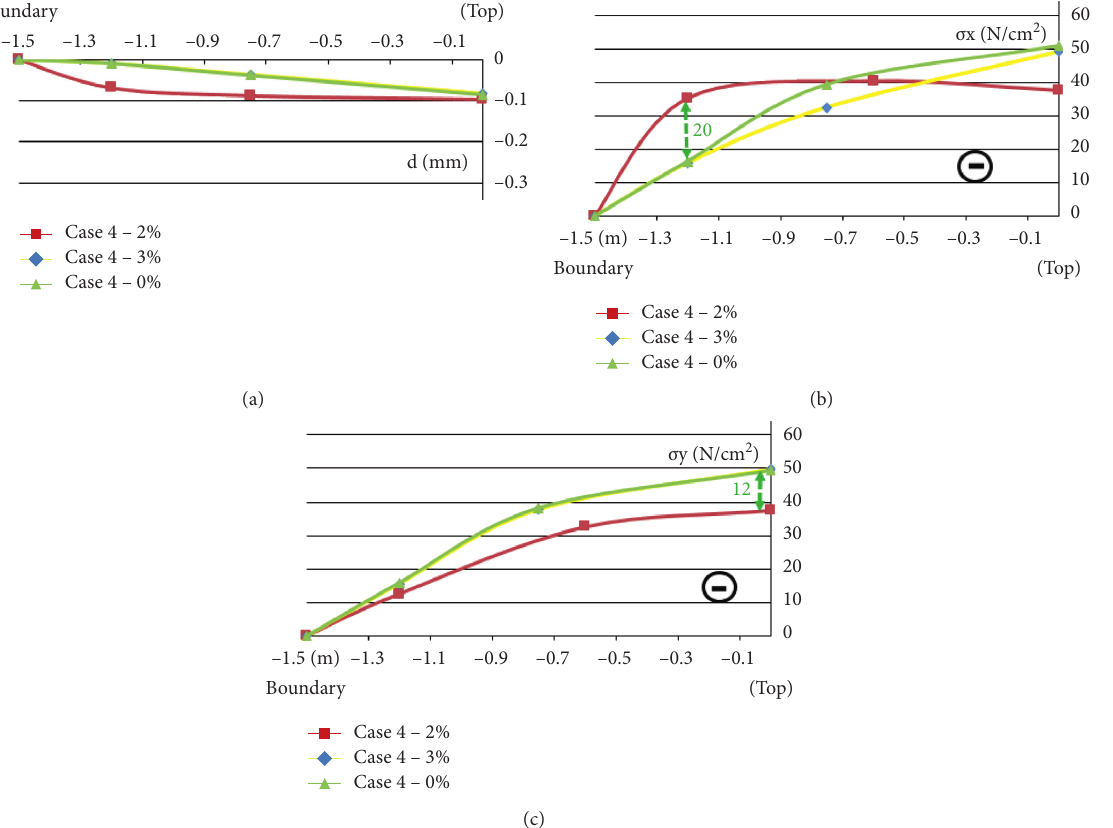
Figure 19: The change of percentage of steel fibres in concrete (Case 4): (a) vertical displacement of the shell; (b) stress σ σ y of